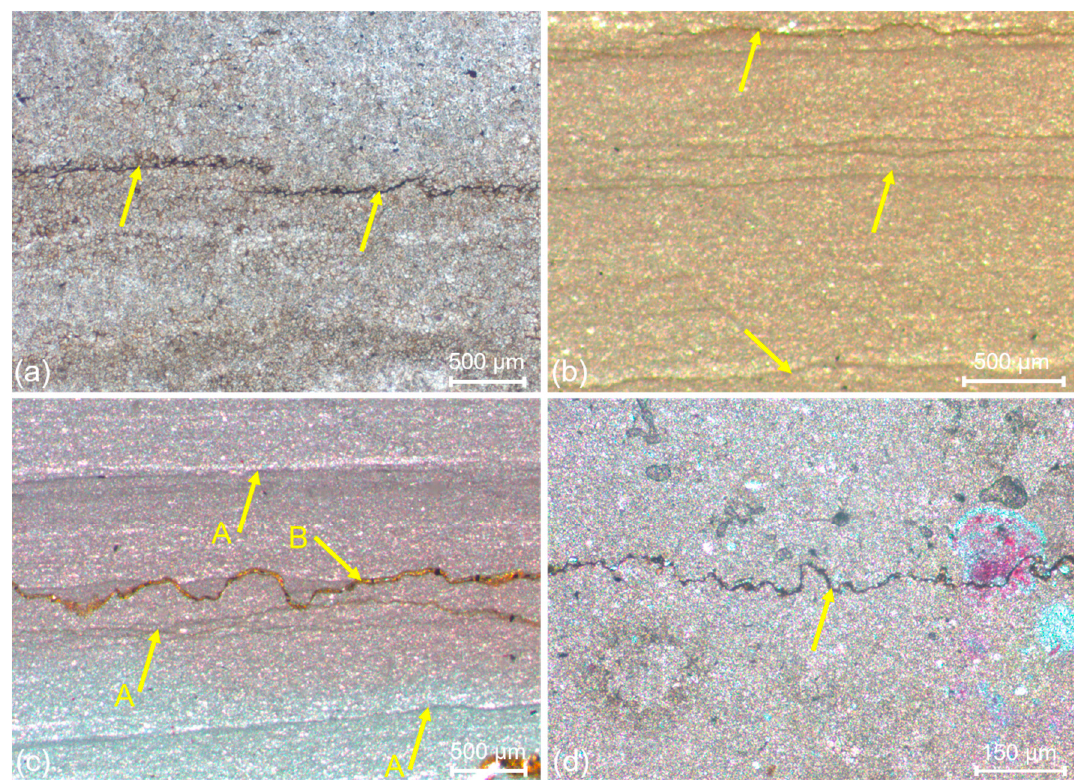
Figure 9. Pressure-solution fractures in thin sections. ( a ) Bed-parallel fractures in Well R2, depth 5041.27 m (16,539.60 ft). ( b ) Bed-parallel fractures in Well R8, depth 4861.80 m (15,950.79 ft). ( c ) Fractures in Well R8, depth 4862.12 m (15,951.84 ft). A is the bed-parallel fracture. B is the stylolite. ( d ) Stylolite in Well R9, depth 4548.53 m (14,923.00 ft). The directions of these thin sections are parallel to the wellbore.